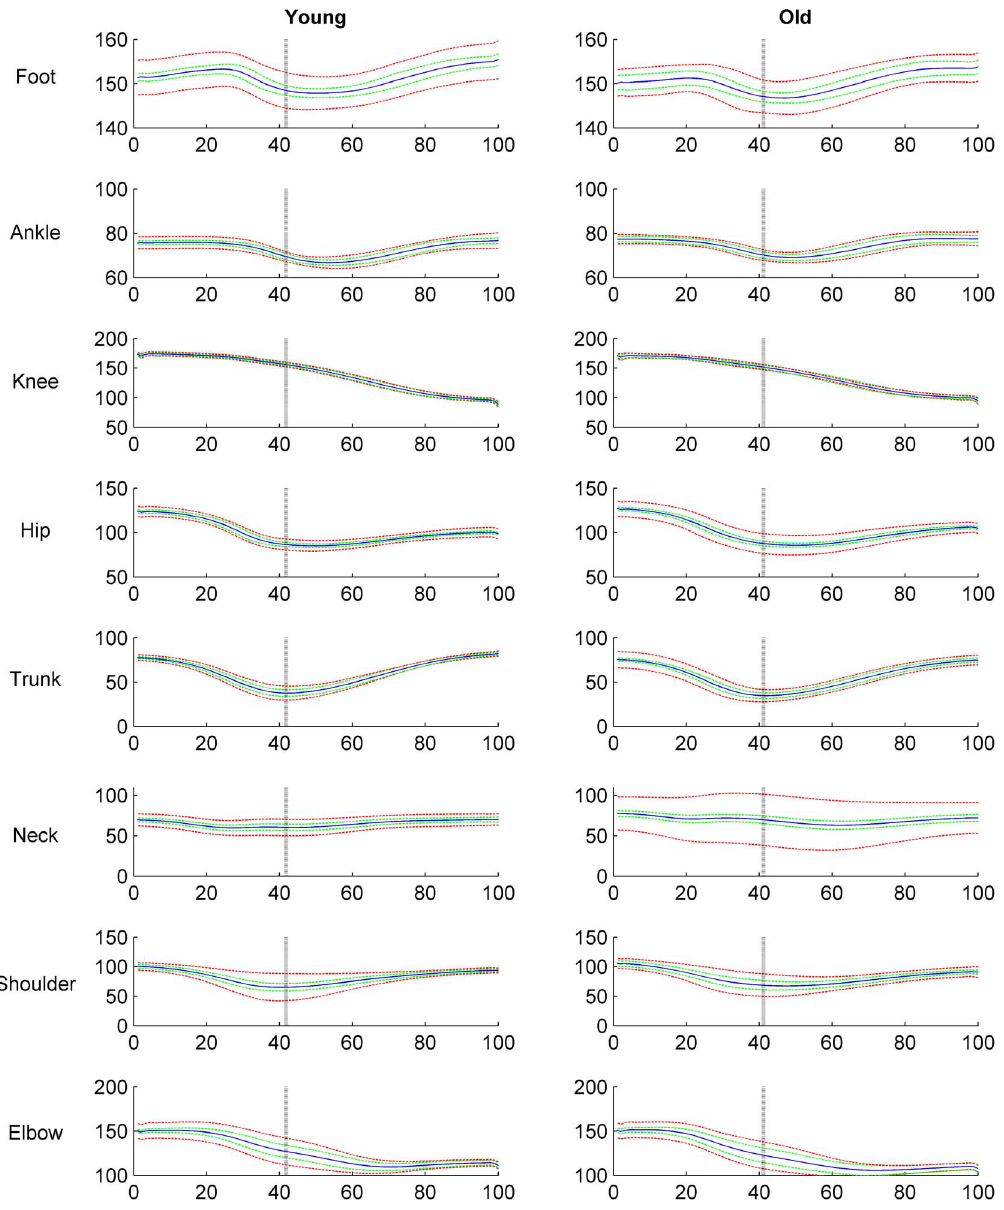
Figure 1. Time normalized Joint position data in young and old participants. The black line gives the mean, the dashed green line gives the standard deviation and the red line gives the standard error of the mean of the time normalized joint position data in degrees of the foot, ankle, knee, hip, trunk, neck, shoulder and elbow with the horizontal surface of the earth in young and old participants. Joint angles were calculated as depicted in figure 2 of Scholz et al 1999 [18]. The vertical dotted black line indicates time where lift-off